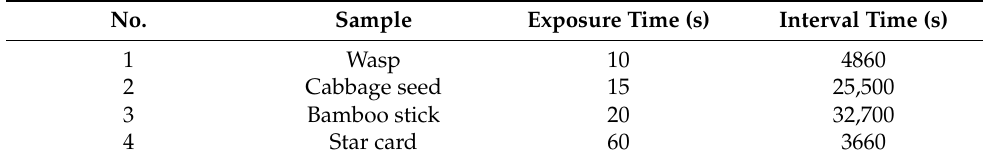
Table 3. Scan sample and exposure time.